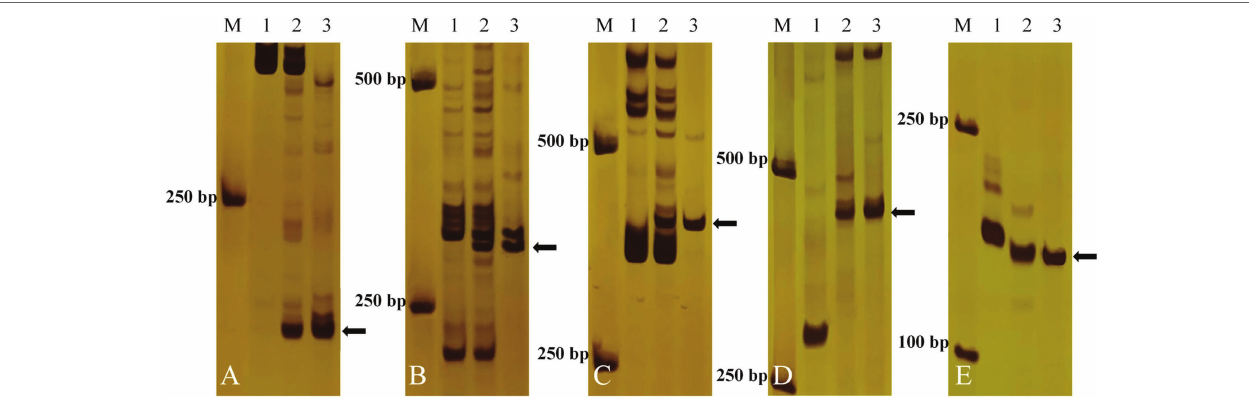
FIGURE 3 | Expressed sequence tag (EST)-sequence-tagged site (STS) marker analysis of E24-3-1-6-2-1 and its parents. Five pairs of EST-STS markers [ (A) BE442811, (B) BE44606, (C) BQ161513, (D) BF473854, and (E) CD373484] corresponding to homoeologous Group 4 amplified the Ns chromosome-specific bands in the E24-3-1-6-2-1 line and P. huashanica . Lane M: DL2000 marker; Lane 1: line 7182; Lane 2: line E24-3-1-6-2-1; and Lane 3: P. huashanica . Diagnostic amplification products of the Ns genome are indicated by